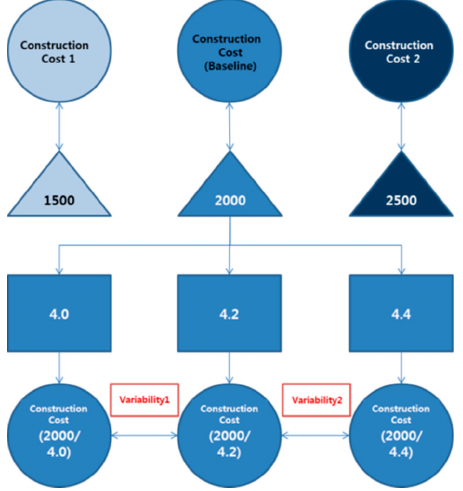
Figure 3. First-order model estimation process based on volatility.